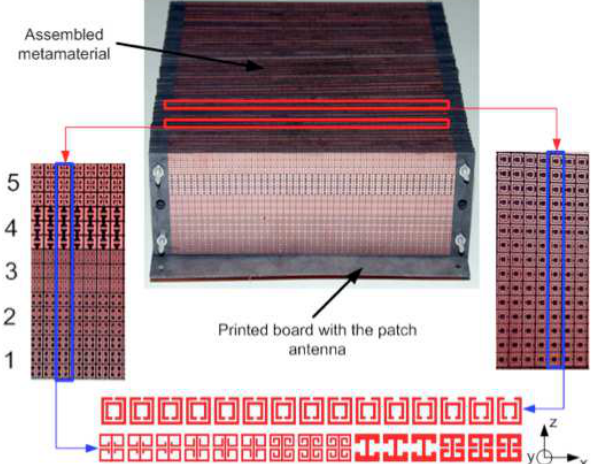
Figure 2: Photography of the structure of the antenna. The inserts show the permittivity (left) and the permeability (right) layers of the